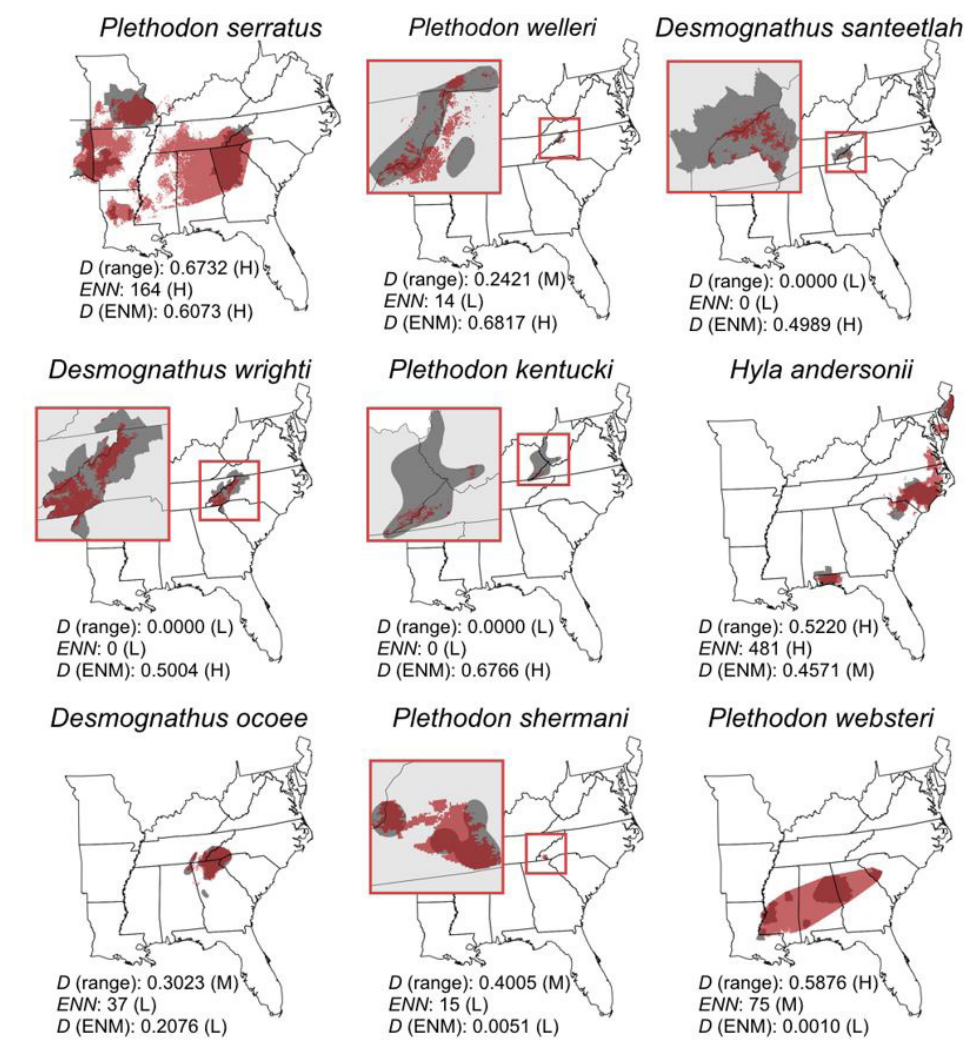
Figure 3. Examples of ENMs (red), overlaid onto county-based ranges (gray). Dark red: overlap of range map and ENM. H: high, M: moderate, L: